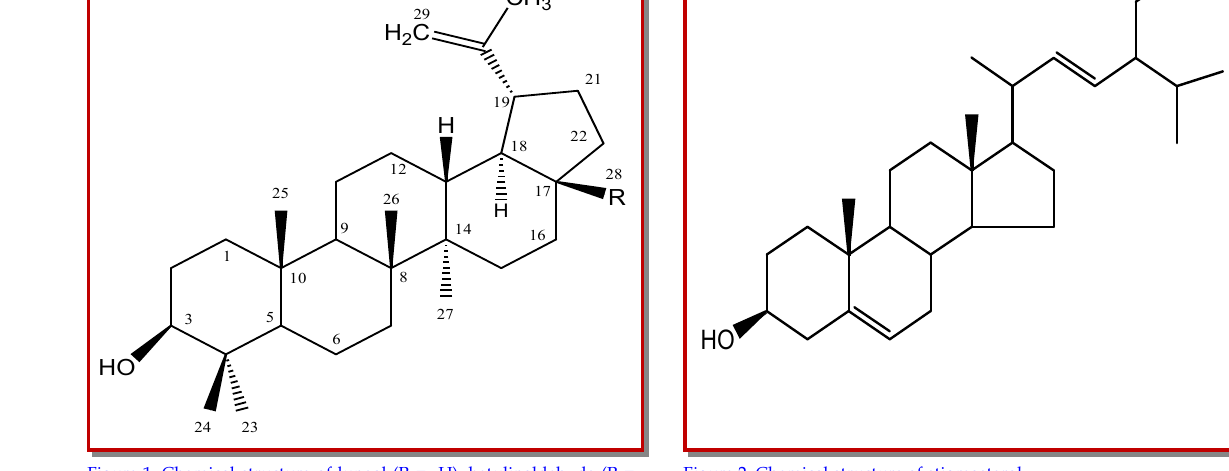
CHO) and betulinic acid (R = -COOH)